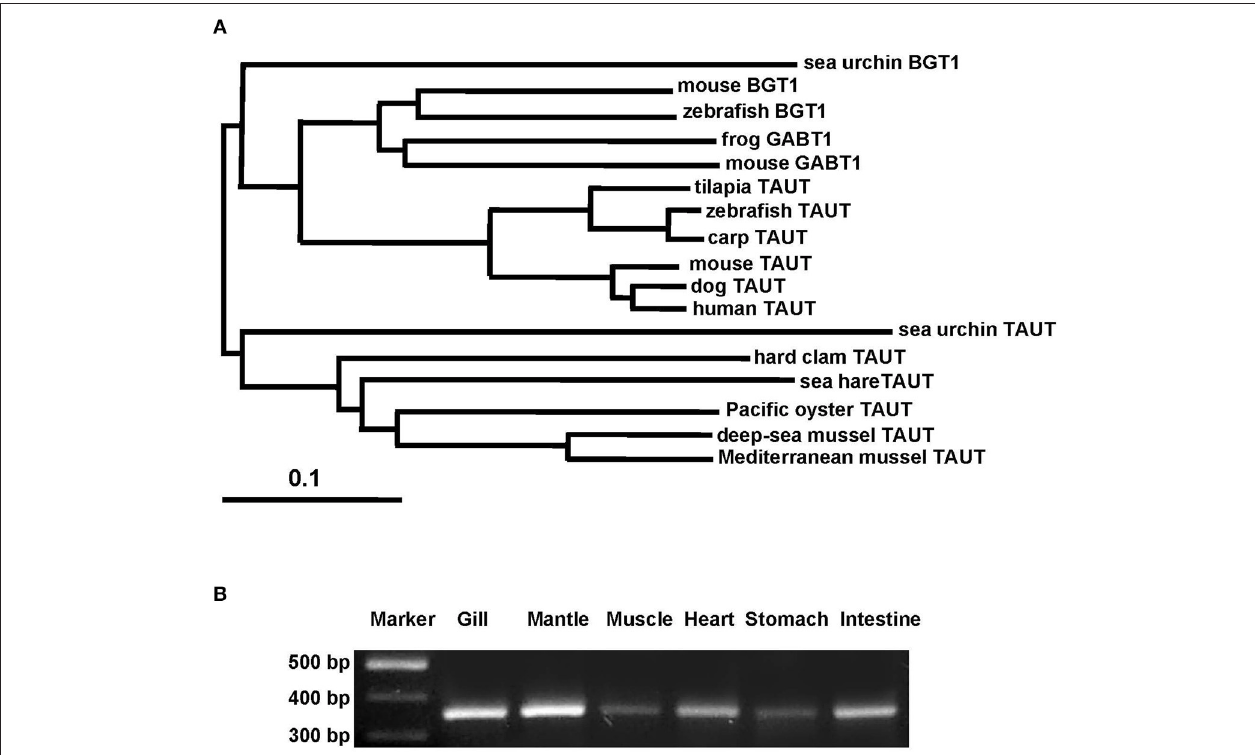
FIGURE 5 | Phylogenetic analysis of taurine transporter (TAUT) (A) and the tissue distribution of TAUT gene expression (B) in the hard clam. (A) Full-length amino acid sequences of TAUT from different species were used to construct a phylogenetic tree by the neighbor-joiningmethod with 1000 bootstrap replicates. Percentages of bootstrapping branch corrections are shown beside the branches, and the ortholog relationships of clades are labeled on the right side to indicate different subtree regions. The GenBank accession nos. of the sequences used are as follows: Mediterranean blue mussel TAUT, BAD91313; deep-sea mussel TAUT, BAF95543; Pacific oyster TAUT, NP_001292278;sea hare TAUT, NP_001191394; sea urchin TAUT, XP_011676091carp TAUT, BAA89537; zebrafish TAUT, NP_001032750; tilapia TAUT, BAB18038; mouse TAUT, NP_033346; human TAUT, AAC50443; dog TAUT, NP_001003311; mouse BGT1, NP_598422; frog BGT1, XP_012815540;sea urchin BGT1, XP_785498; sea urchin GABT1, XP_784181; zebrafish GABT1, NP_001007363;mouse GABT1, NP_848818. (B) For the tissue distribution of TAUT gene expression, fragments were amplified by using gene-specific PCR primers. The TAUT is expressed in the gill, mantle, muscle,